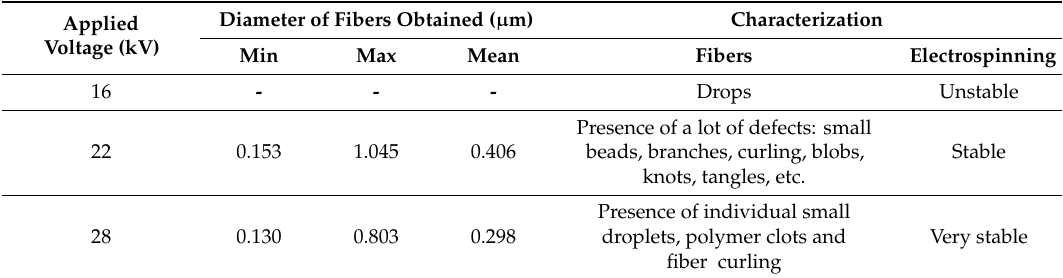
Table 1. Characterization of the electrospinning and curcumin / usnic acid-loaded fibers obtained. Diameter of Fibers Obtained ( µ Applied Voltage (kV)